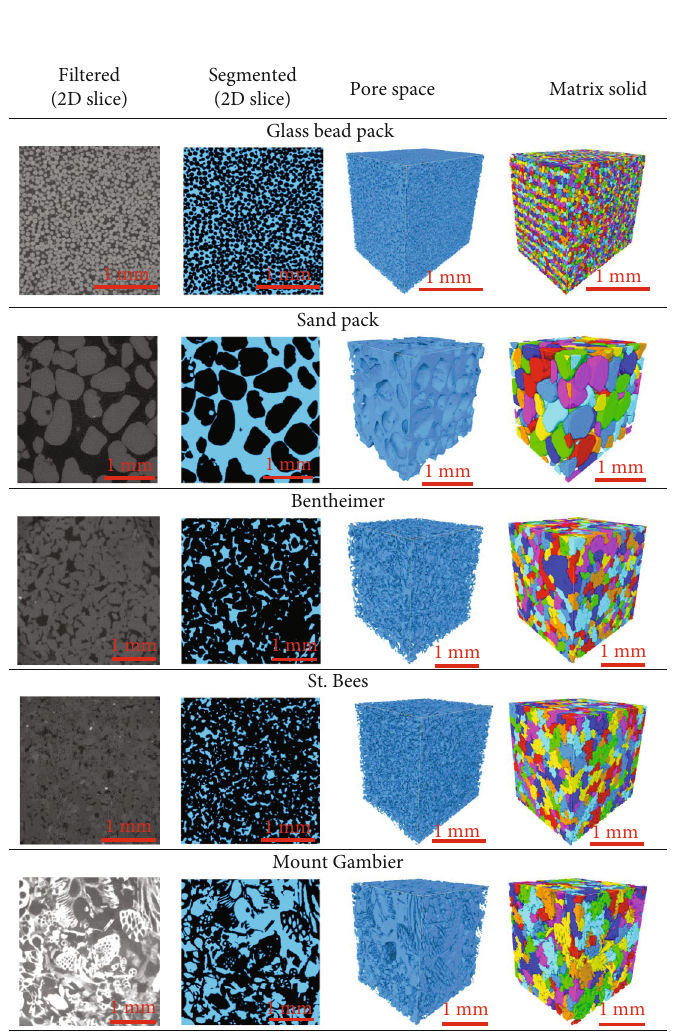
Figure 2: From left to right: raw 2D image slice through each porous medium (dark =pore space; grey and white=solid phase), segmented 2D image slice (blue =pore space and black=solid phase), 3D pore spaces (blue =pore space and transparent =solid phase), and 3D rock matrix (di ff erent colours indicate di ff erent grain